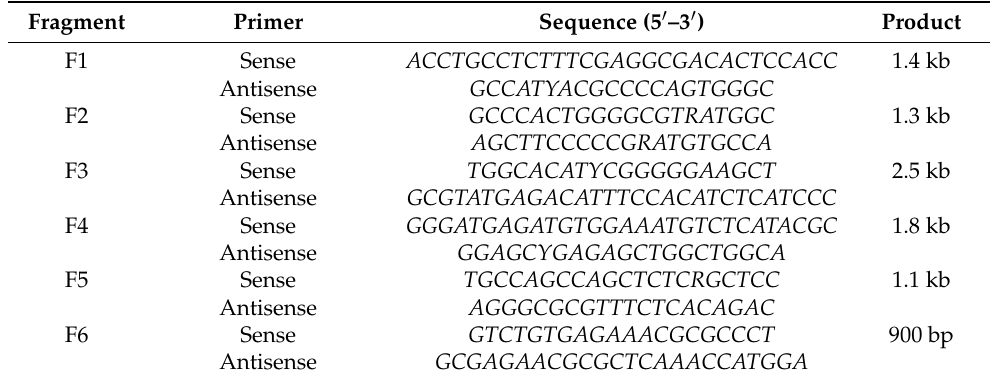
Table 1. Primers used in this